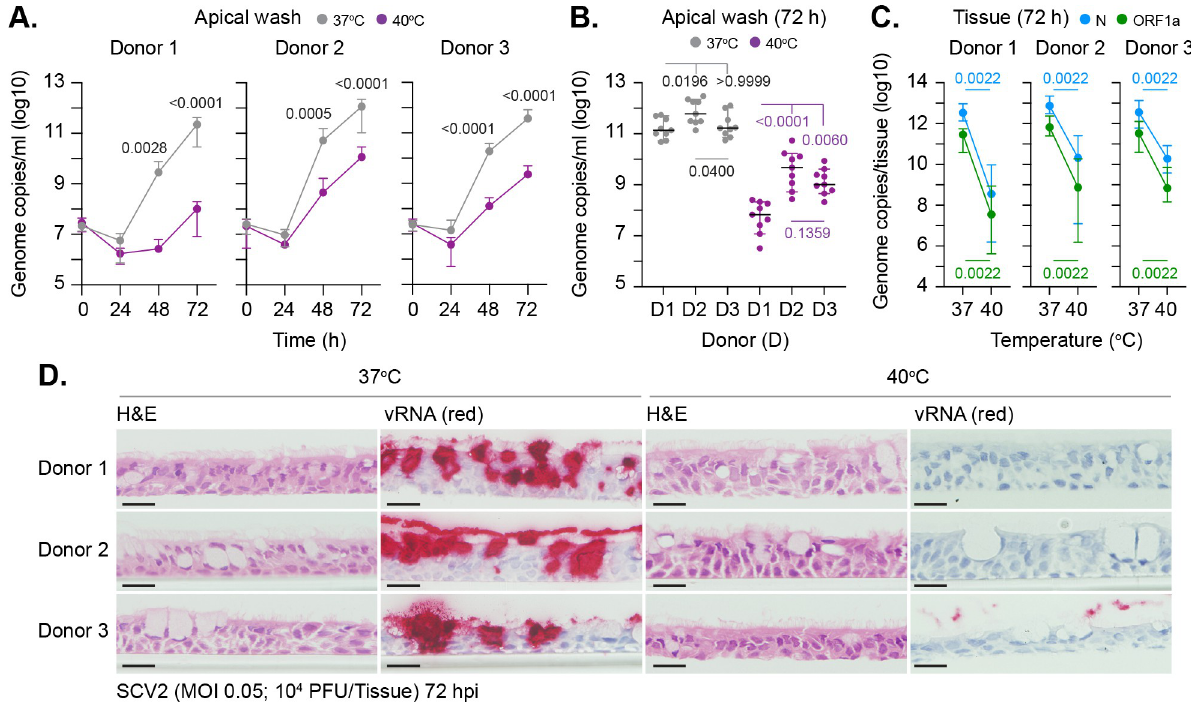
Fig 4. Elevated temperature restricts SARS-CoV-2 replication in respiratory airway cultures in a donor-independent manner. Ciliated respiratory cultures differentiated from primary HBEp cells isolated from 3 independent donors (donor 1, male Caucasian aged 63 years; donor 2, Hispanic male aged 62 years; donor 3, Caucasian female aged 16 years; all nonsmokers) were incubated at 37 or 40˚C for 24 h prior to SARS-CoV-2 (SCV2; MOI 0.05; 10 4 PFU/Tissue) infection and incubation at the indicated temperatures. Apical washes were collected over time (as indicated) and tissues harvested at 72 h for RNA extraction or fixed for ISH staining. (A/B) Genome copies per ml of SARS-CoV-2 in apical washes harvested over time as determined RT-qPCR. N = 9 tissues per condition derived from a minimum of 3 independent biological experiments. (A) Means and SD shown; p -values shown, Mann–Whitney U test between donor paired time points. (B) Black line, median; whisker, 95% confidence interval; all data points shown; p -values shown, one-way ANOVA Kruskal–Wallis test (top), Mann–Whitney U test (bottom). (C) Quantitation of genome copies per tissue of SARS-CoV-2 at 72 h by RT-qPCR using 2 independent primer probe sets (N and ORF1a). N = 6 tissues per sample condition derived from a minimum of 3 independent biological experiments. Medians and 95% confidence interval shown; p -values shown, Mann–Whitney U test. (D) Representative images of H&E and SARS-CoV-2 RNA ISH (red) stained sections. Hematoxylin was used as a counter stain. Scale bars = 20 μ m. Raw values presented in S9 Data. HBEp, human bronchiolar epithelial; H&E, hematoxylin and eosin; ISH, in situ hybridization; PFU, plaque-forming unit; RT-qPCR, reverse transcription quantitative PCR; SARS-CoV-2, Severe Acute Respiratory Syndrome Coronavirus 2; vRNA, viral RNA.